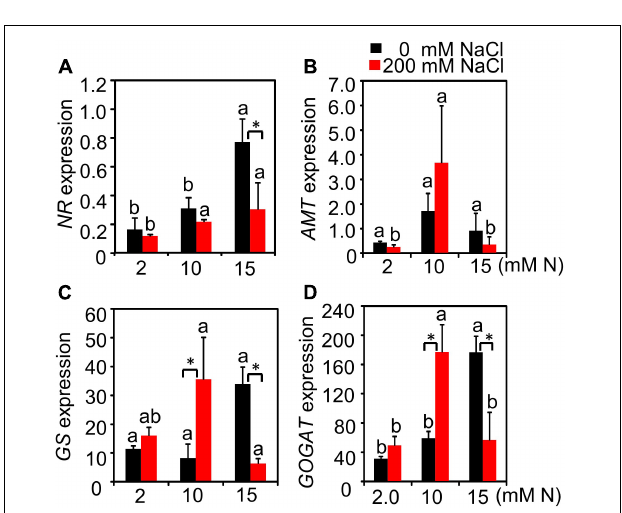
FIGURE 5 | Relative expression level of N metabolism-related genes of bermudagrass under different treatments. The expression level of NR (A) , AMT (B) , GS (C) , and GOGAT (D) in the leaves of bermudagrass grown under different nitrogen concentrations exposed to different NaCl levels (0 and 200 mM NaCl), respectively. Different letters above the columns indicate statistically significant differences at P < 0.05 under different N levels with the same NaCl level by Tukey’s test. ∗ Shows significant differences ( P < 0.05) under 200 mM NaCl treatment and 0 mM NaCl condition with the same N level by Tukey’s